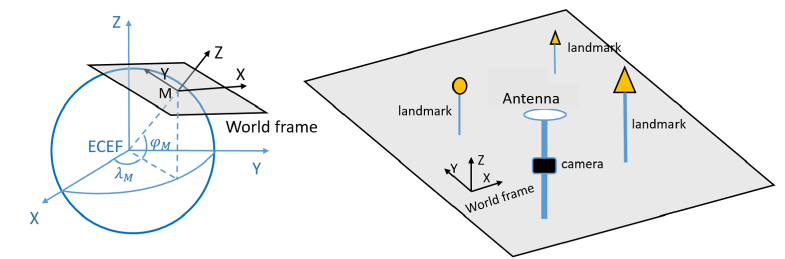
Figure 1. On the left: conversion from [ X , Y , Z ] (ECEF, in blue) to [ X , Y , Z ] (world frame, in black). On the right: visualization of GNSS/monocular vision set up in the world frame. The camera is not necessarily in the origin of the world frame. The world frame is converted with respect to point M with geographic coordinates [ ϕ M , λ M , h M ] , M is the centre of this local topocentric reference coordinate